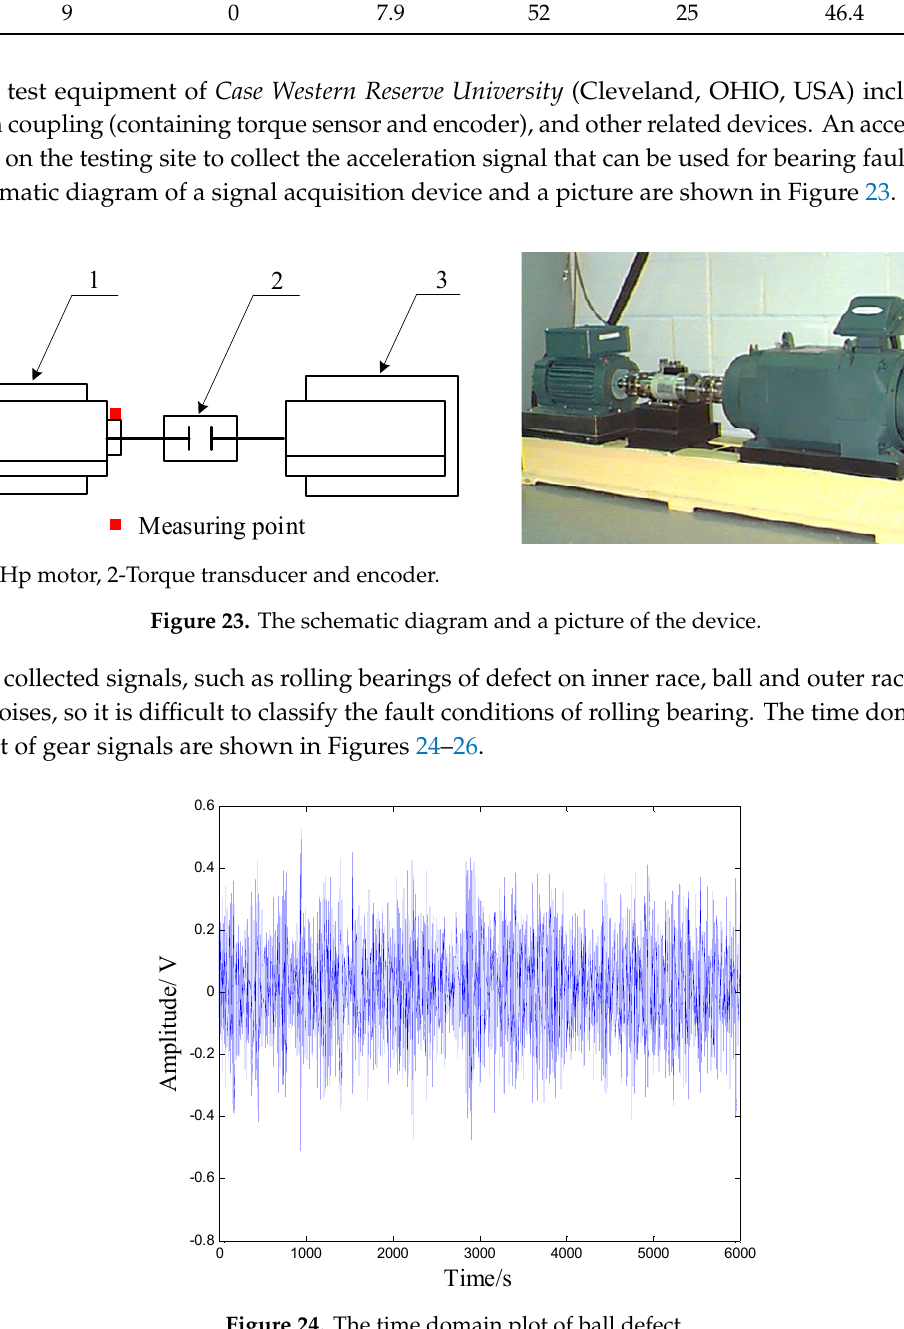
Figure 25. The time domain plot of inner race defect . Figure 26. The time domain plot of outer race defect. It can be seen from Figures 24–26 that the spectral analysis of these groups of signals cannot show the difference between different kinds of rolling bearing faults. Hence, the smooth local subspace projection method is applied to denoise 12 groups of signals for 10 times iteration denoising, and PE values of original vibration signals and denoised vibration signals are calculated, to conduct a fault classification of rolling bearings.